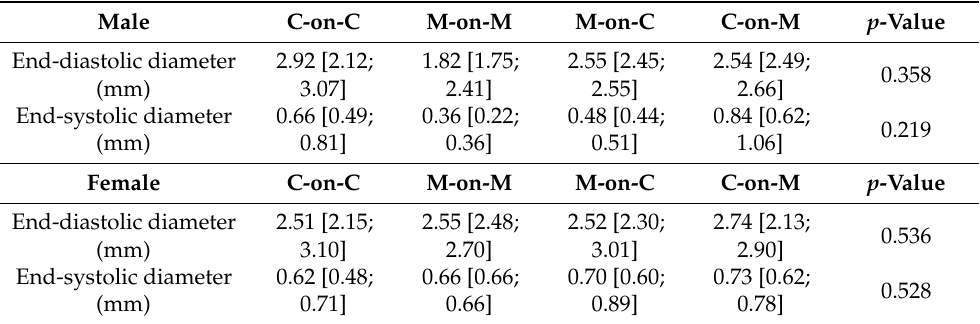
Table 1. End left ventricle dimensions of heart cycles of the offspring at day 21.